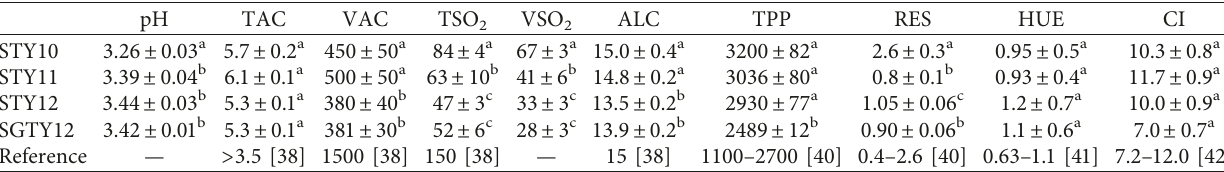
Table 5: Selected fermentation parameters and antioxidant indicators in STY10, STY11, STY12, and SGTY12 bottled wine samples.